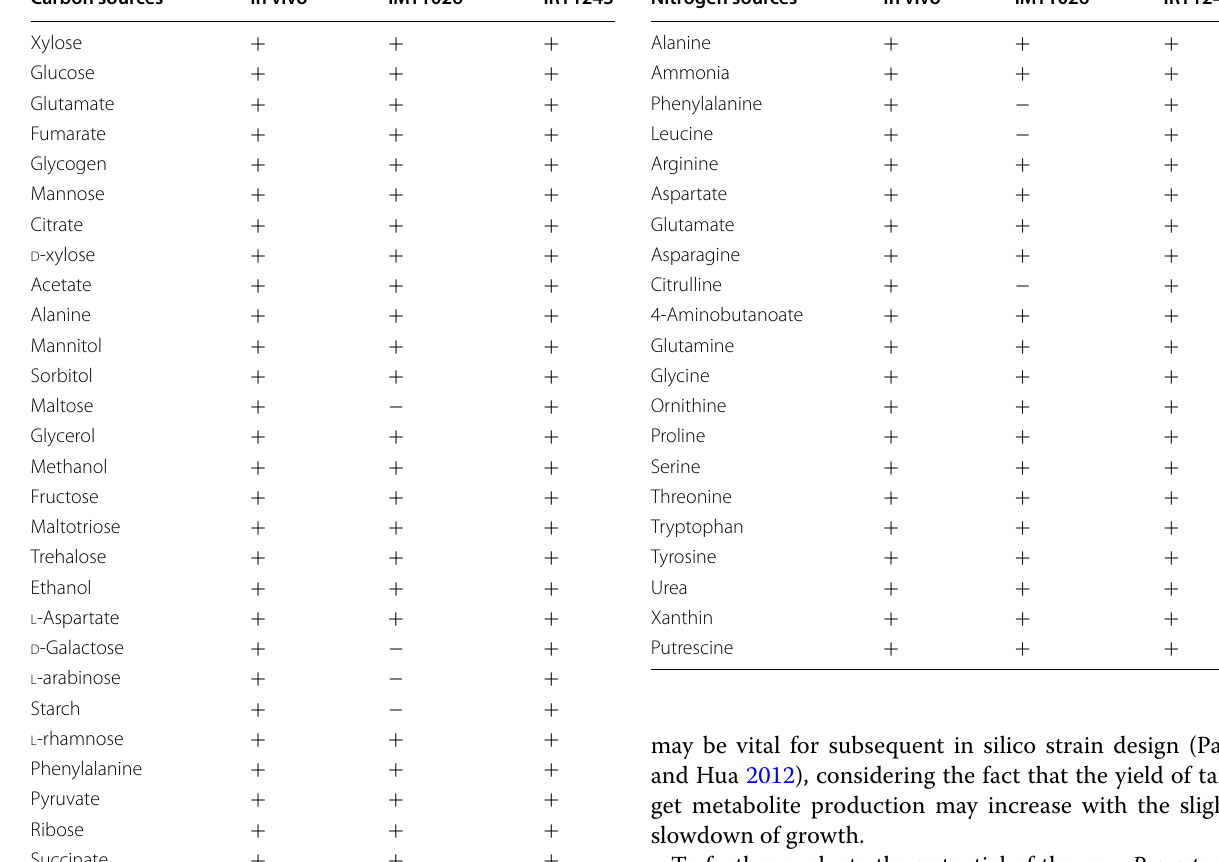
Table 4 Evaluation of growth capabilities of P. pastoris for growth and for non- on different nitrogen sources ( + − growth) Nitrogen